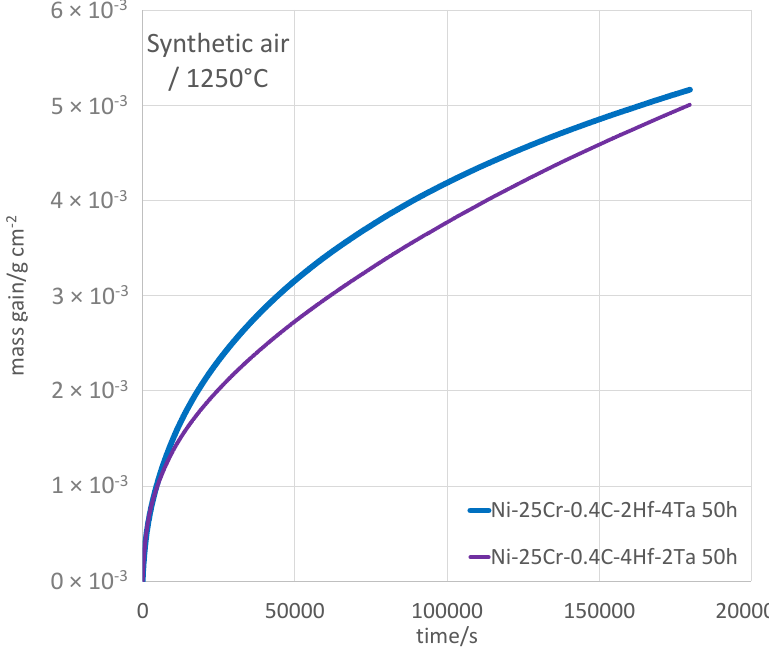
Figure 4. The two {m vs. T}-plotted isothermal mass gain curves obtained for the two